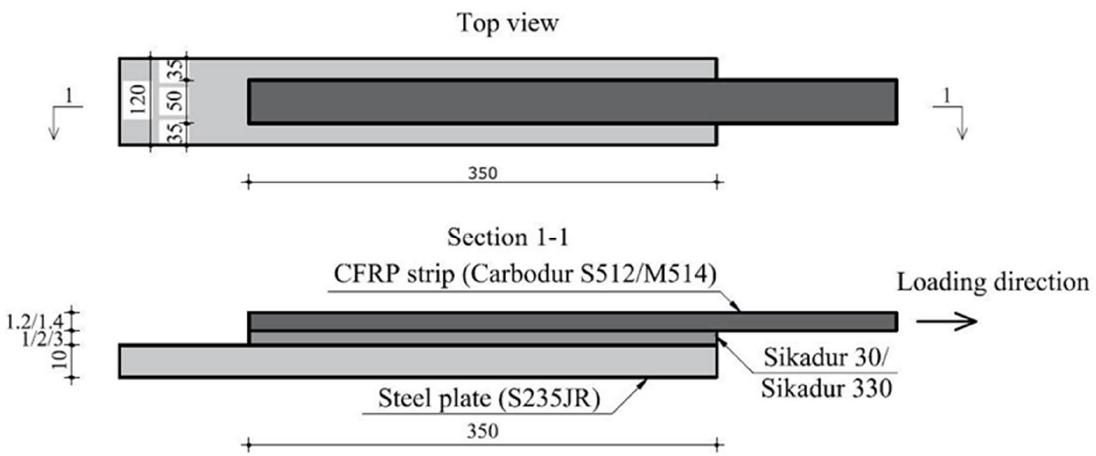
Figure 3. General layout of the specimens.